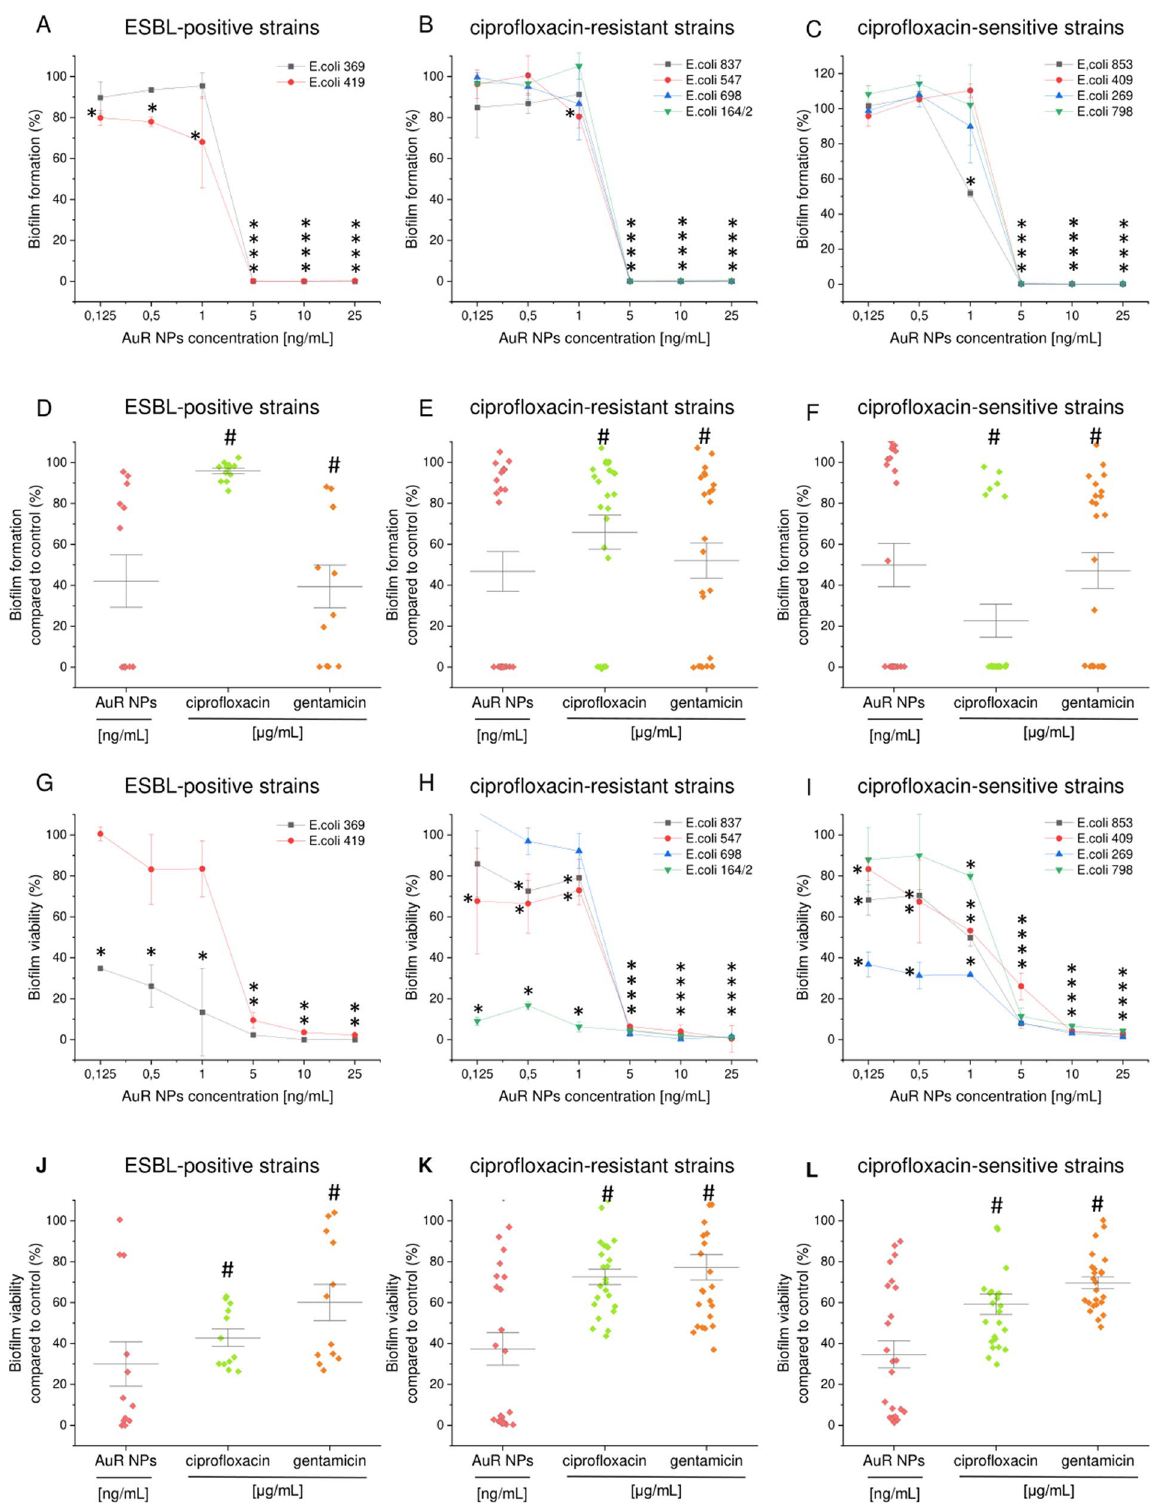
Figure 8. Prevention of biofilm formation by clinical isolates of E. coli ( A – F ) and disruption of pre-formed biofilms ( G – L ) by rod-shaped gold nanoparticles (AuR NPs) compared with ciprofloxacin and gentamicin. The formation of biofilms and viability of disrupted biofilms was assessed using resazurin-based fluorimetric methods after 48 h of cultivating against ESBL-positive ( A , D , G , J ; E. coli 369 and 419), ciprofloxacin-resistant ( B , E , H , K ; E. coli 837, 547, 698 and 164/2), and ciprofloxacin-sensitive ( C , F , I , L ; E. coli 853, 409, 269 and 798) strains. Panels ( D – F ) and ( J – L ) compare the anti-biofilm activities of AuR NPs, ciprofloxacin, and gentamycin in doses ranging from 0.125 to 25 ng mL −1 (for AuR NPs) and 0.125 to 25 µg mL −1 (for ciprofloxacin and gentamycin). * and # indicate statistical significance ( p < 0.05) when compared to untreated control samples and nanoparticles-treated bacteria,